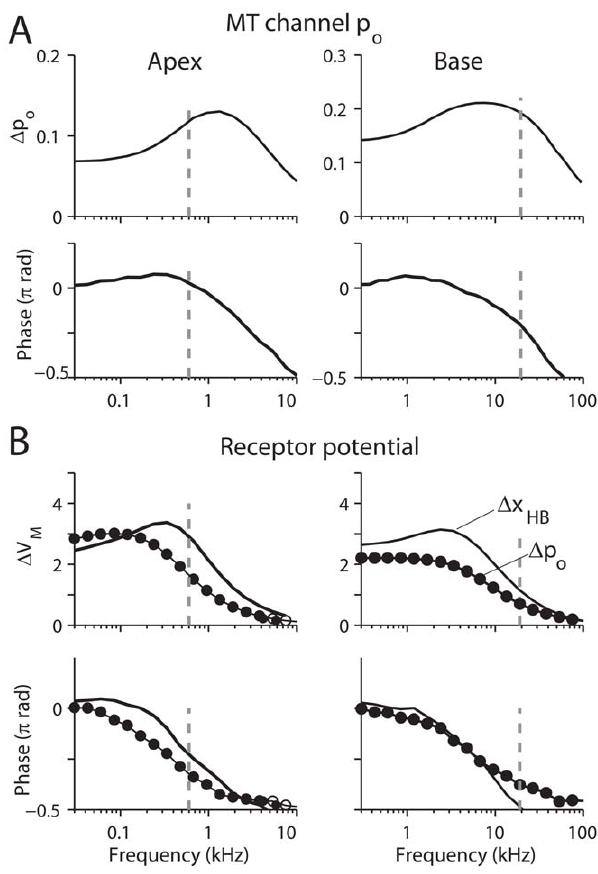
Figure 3. Response of a single OHC to hair bundle stimuli. ( A ) An OHC hair bundle was stimulated with a sinusoidal force applied at the tip of the bundle with amplitude 20 pN (left, apex) and 100 pN (right, base). Change in probability of opening of the transduction channel D p o (top) and phase with respect to the applied force (bottom) are plotted versus stimulation frequency. ( B ) An OHC was stimulated N either by sinusoidal modulation of the mechano-transduction channel , p o =0.4 + 0.05sin( v t ) ) or open probability about a mean value of 0.4 ( by sinusoidal hair bundle displacement (solid lines, x HB = x O sin( v t ) where x O =3.3. nm, left apex, or x O =1.0 nm, right, base) at different frequencies. The amplitude of the OHC receptor potential ( D V M , (top) and its phase with respect to the stimulus (bottom) are shown. The BF at each OHC’s location (0.60 and 19 kHz) is indicated with broken vertical lines.